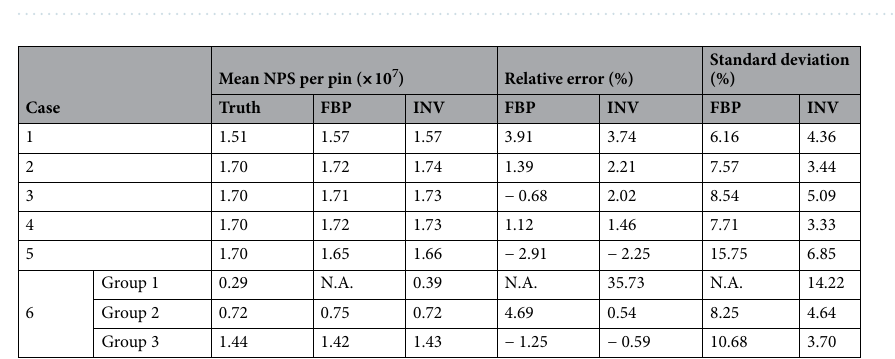
Figure 11. Activity distribution based on FBP. The pin activity was estimated by multiplying a normalization constant to the sum of all pixels inside the pin.The ground truth is shown as the red line.